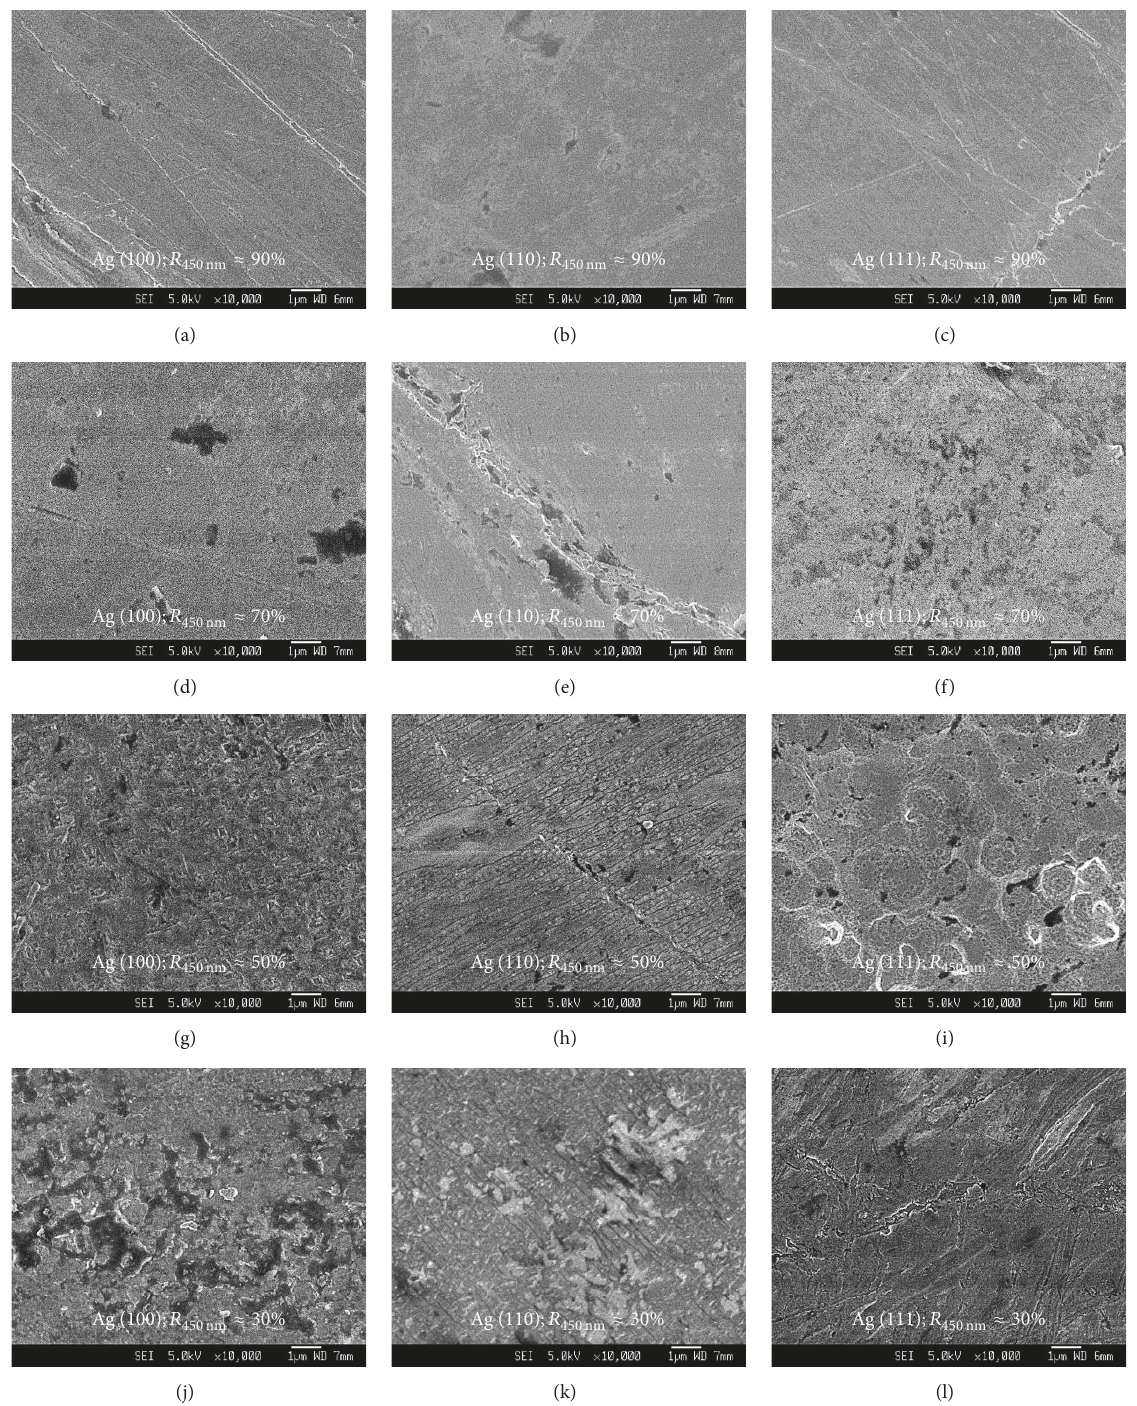
Figure 4: Surface morphologies of single crystal Ag (100), Ag (110), and Ag (111) with different specular reflectance (a)–(c) 𝑅 450 nm ≈ 90%; (d)–(f) 𝑅 450 nm ≈ 70%; (g)–(i) 𝑅 450 nm ≈ 50%; (j)–(l) 𝑅 450 nm ≈ 30%.